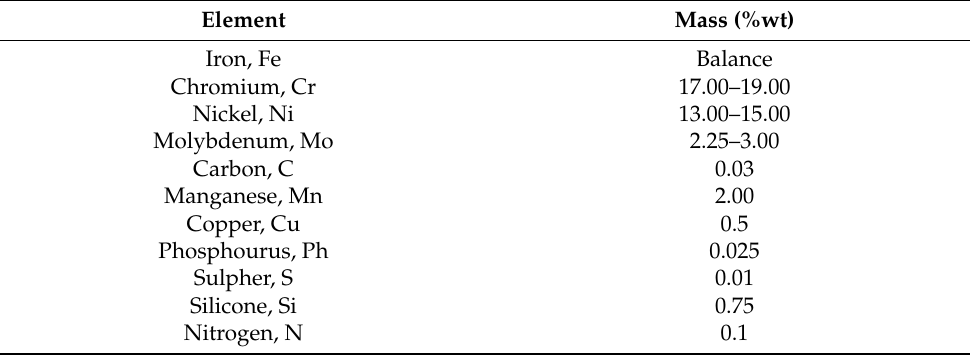
Table 1. 316L Powder chemical composition as per Material Data Sheet